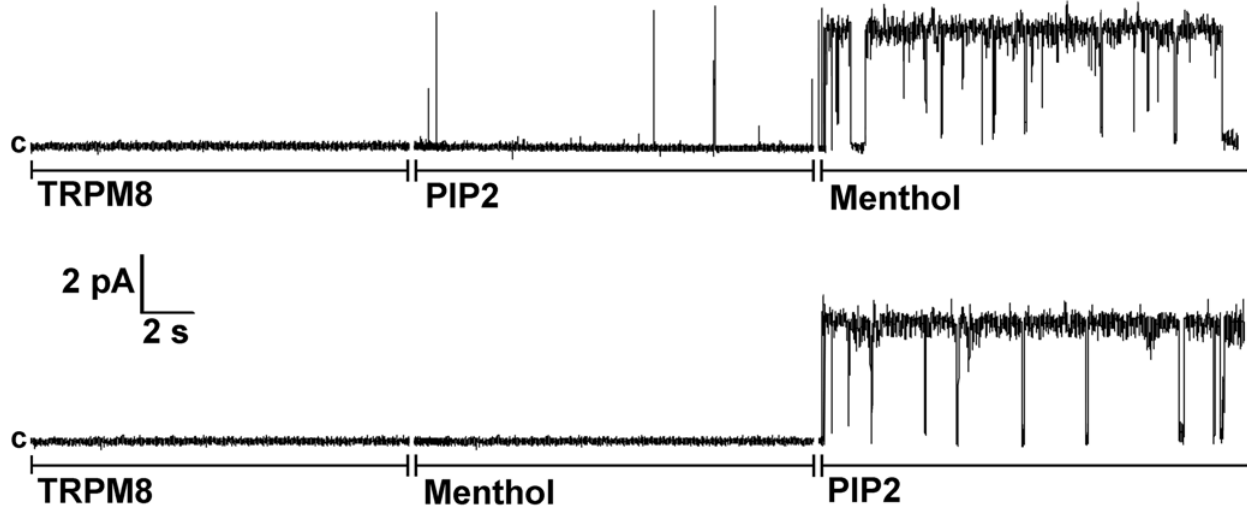
Figure 5. Activation of TRPM8 channels in Planar Lipid Bilayers by menthol and PtdIns(4,5)P 2 . Representative single-channel current recordings of TRPM8 channels incorporated in planar lipid bilayers formed from POPC/POPE (3:1) in n -decane, between symmetric bathing solutions of 150 mM KCl, 0.2 mM MgCl 2 in 20 mM Hepes buffer, pH 7.4 at 22 u C. 0.2–0.5 m l of 0.2 m g/ml TRPM8 protein (isolated from the plasma membrane of HEK-293 cells stably expressing TRPM8) was incorporated in POPC/POPE micelles, which were added to the cis compartment (ground). Clamping potential was + 60 mV. Data were filtered at 50 Hz. Upper and lower traces consist of three segments with additions of components as indicated in the figure: 2 m M of diC 8 PtdIns(4,5)P 2 and 500 m M of menthol were added to both compartments. The current recordings are representative of a total of 22 independent experiments for the upper traces and 12 independent experiments for the lower traces.